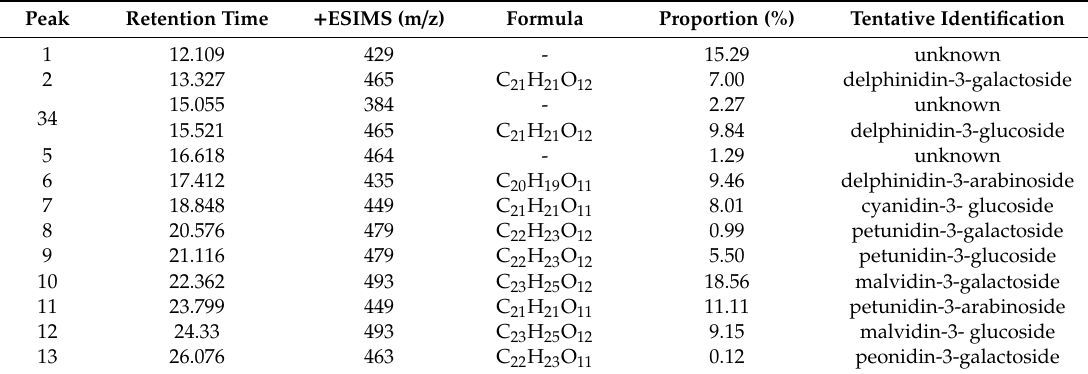
Figure 1. High performance liquid chromatography (HPLC) chromatogram of anthocyanins in blueberry pomace. Table 1. Identification of anthocyanins in blueberry pomace using liquid chromatography-mass spectrometry